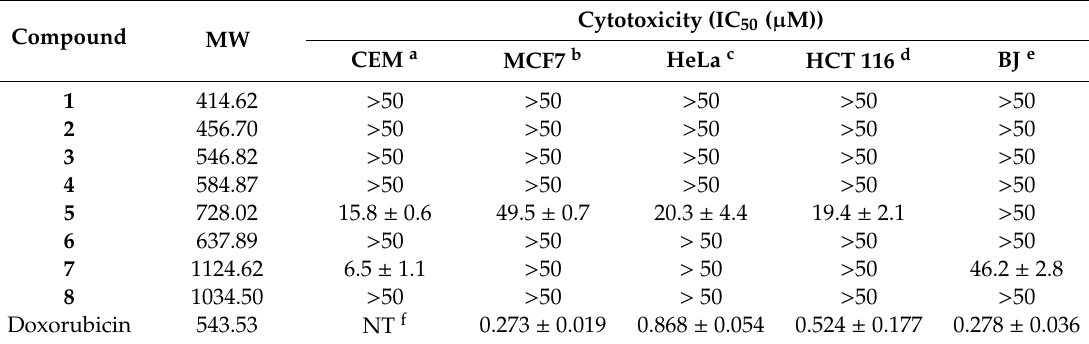
Table 3. Cytotoxicity screening tests (IC 50 values ( µ M), 72